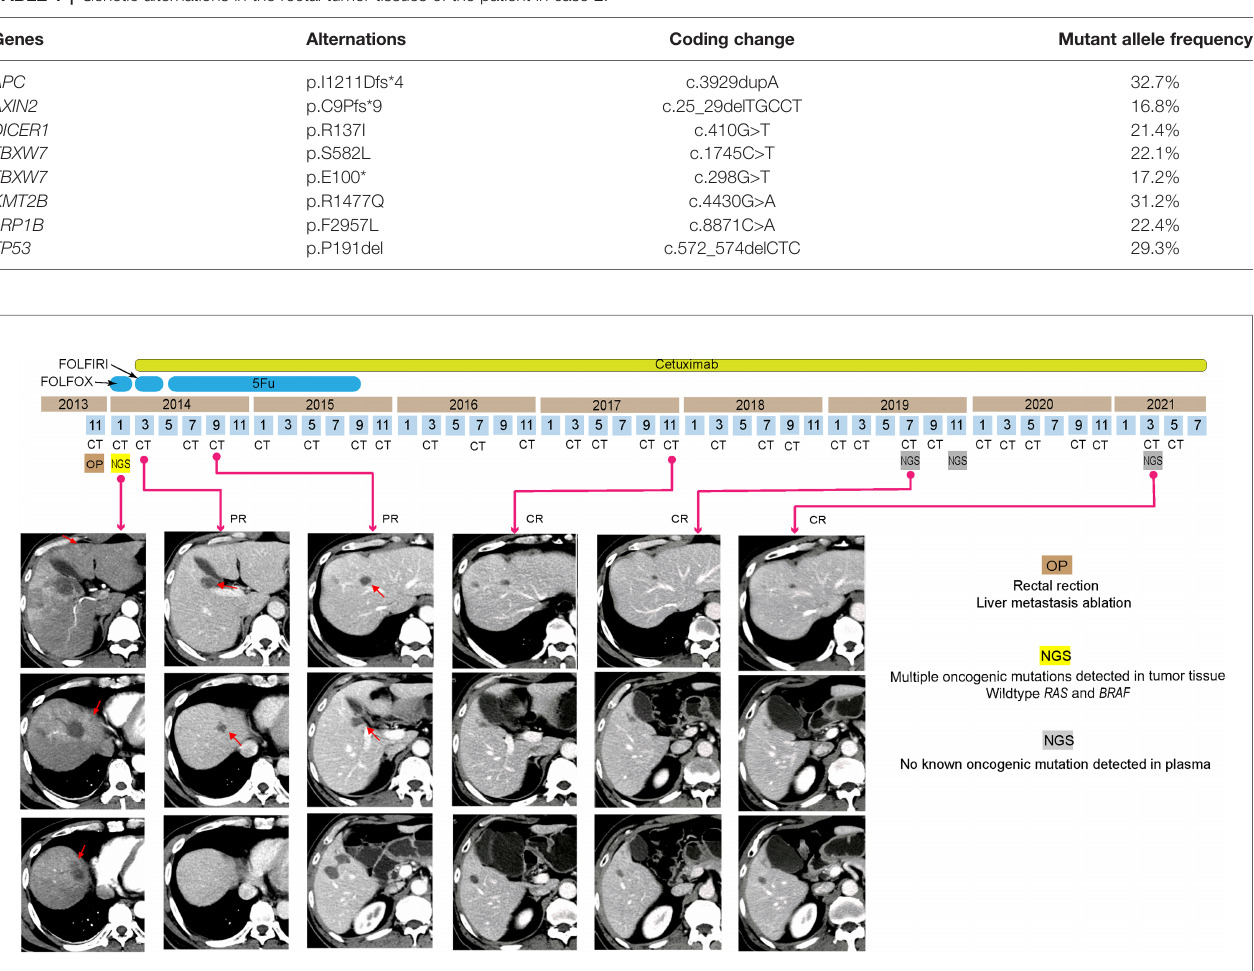
FIGURE 2 | Tumor progression of the patient in case 2. Computed tomography images indicated the shrinkage and disappearance of the hepatic nodules (indicated by red arrows). PR, partial respond; CR, complete